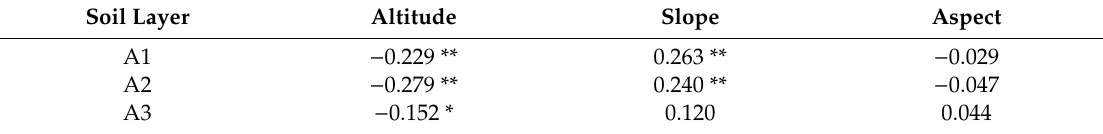
Table 4. Correlation analysis of soil iron contents with di ff erent topographic factors. Soil Layer Altitude Slope Aspect